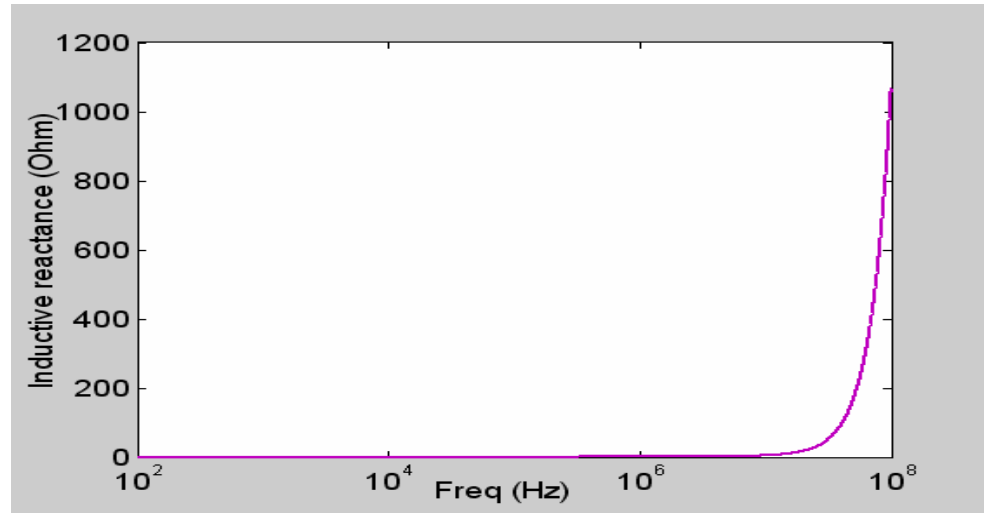
Figure 15. Variation of reactance with frequency for mesh sensor.